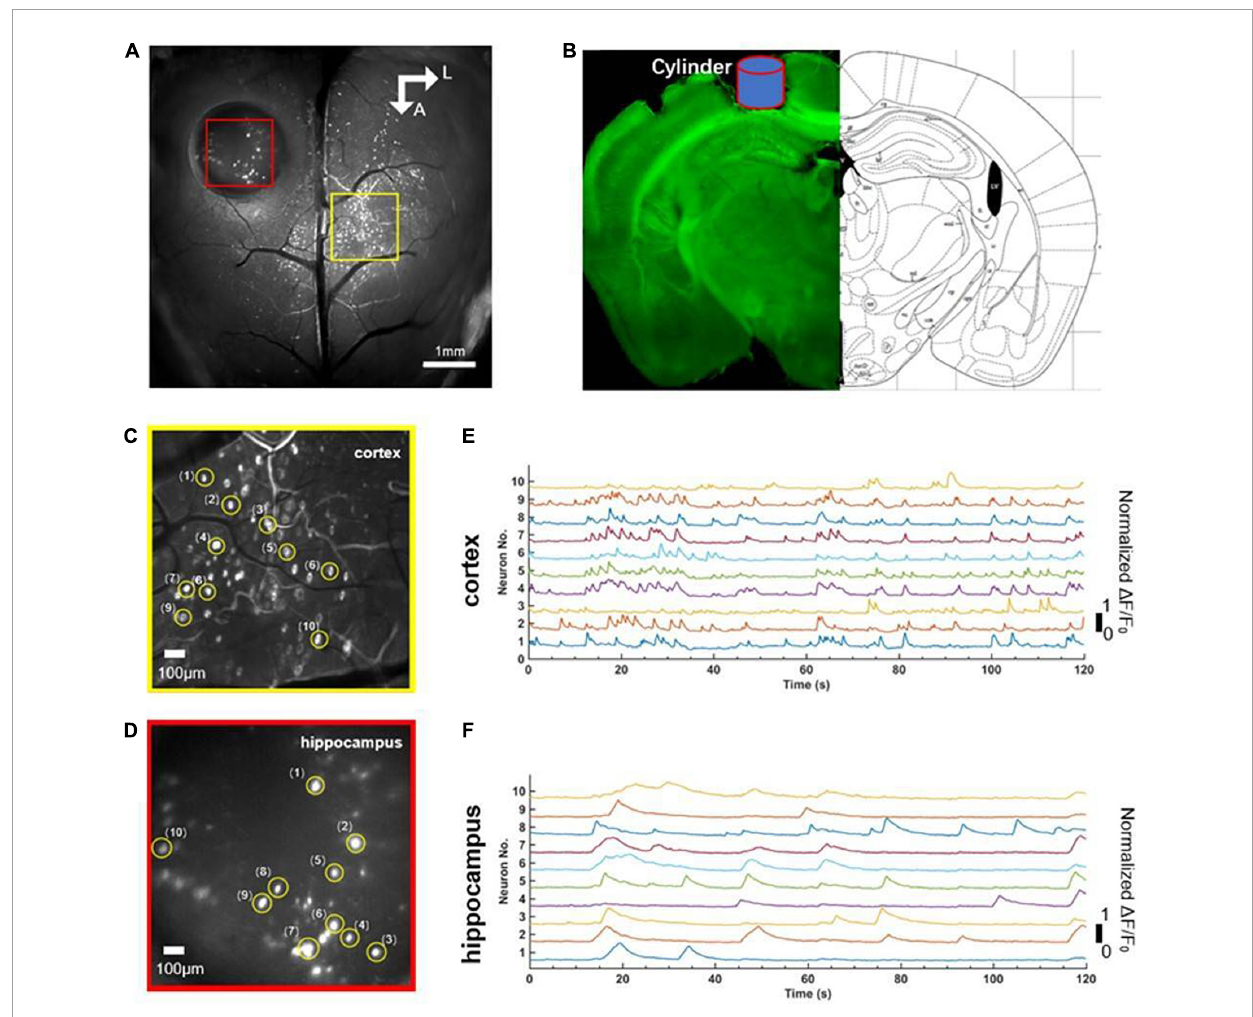
FIGURE2 Comparison of simultaneous wide-field calcium imaging of cerebral cortex and hippocampus CA1 in vivo in awake states. (A) Photograph illustrating simultaneous wide-field calcium imaging in vivo of the cerebral cortex and the hippocampus CA1. Scale bar, 1 mm. (B) Coronal slice of the mouse illustrating the hippocampus CA1 right beneath cylinder (blue) corresponding to the red square in panel (A) . (C) A field of the enlarged view of neurons (labeled 1–10) in layer 2/3 of cerebral cortex indicated with the yellow square in (A) , Scale bar, 100 µ m. (D) A field of the enlarged view of neurons (labeled 1–10) of hippocampus CA1 indicated with the red square in (A) , Scale bar, 100 µ m. (E) Normalized fluorescence signals fluctuation ( (cid:49) F/F 0 ) for neurons (labeled 1–10) shown in panel (C) . (F) Normalized fluorescence signals fluctuation ( (cid:49) F/F 0 ) for neurons (labeled 1–10) shown in panel (E)